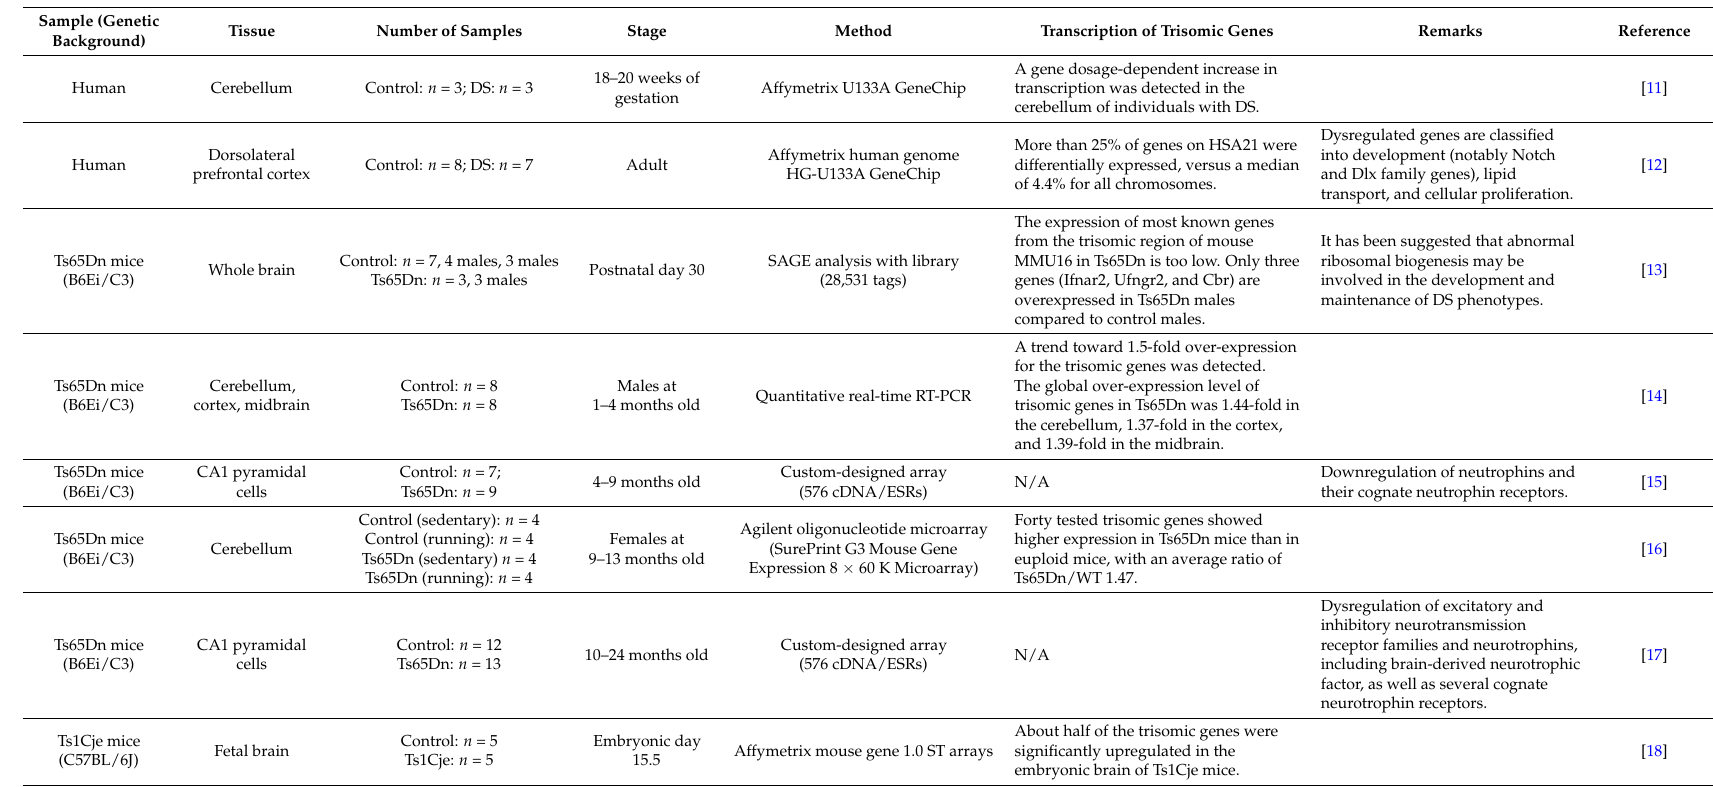
Table 1. A comparative transcriptomic analysis of the brain with